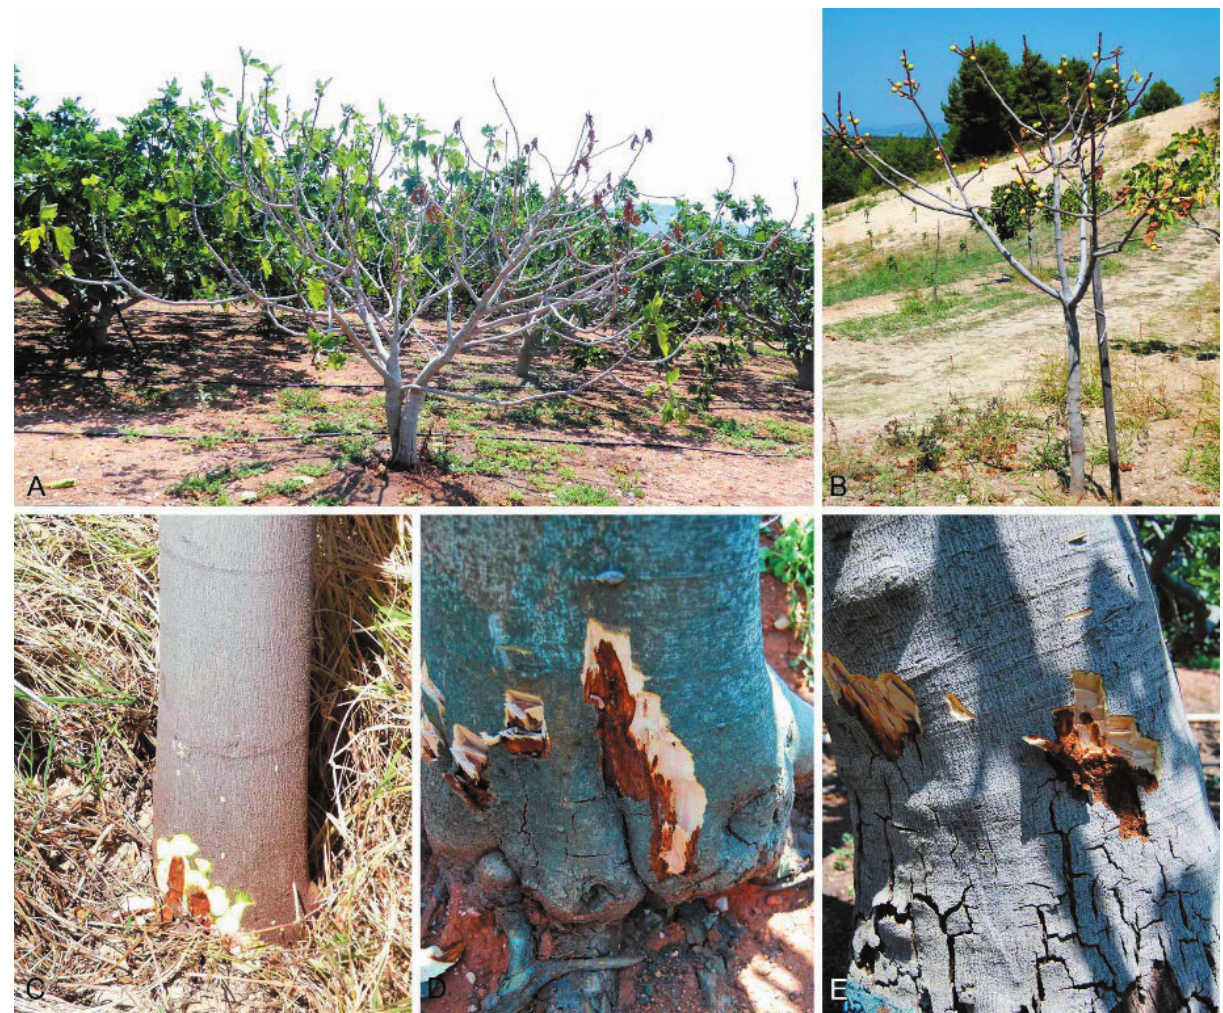
Figure 1. Field images of infected fig trees. A, infected mature tree of Vasilika honey-white cultivar with symptoms of leaf wilt and defolia- tion; B, infected young tree of Smyrna cultivar defoliated at the end of summer, with some of the unripe fruit still on the tree; and C, D and E, cankers at the bases of Ficus carica trees, with extensive wood staining under the dead